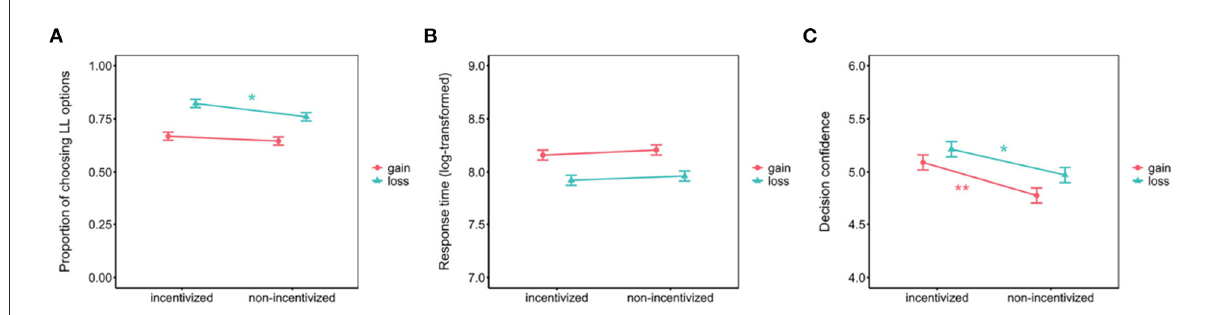
FIGURE2 Behavioral results of (A) proportion of choosing LL options, (B) response time, and (C) decision confidence in the present study. Error bars represent 95% CI. ∗ p < 0.05, ∗∗ p <